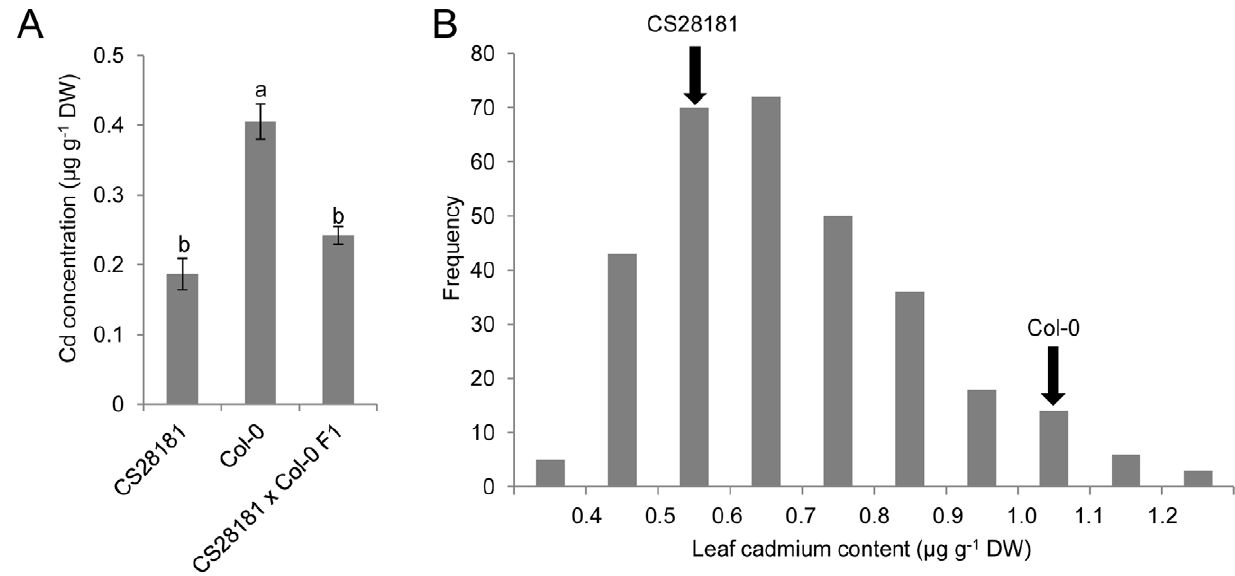
Figure 2. High leaf Cd in A.thaliana Col-0 is recessive to the low leaf Cd in the CS28181 accession. A. Leaf Cd concentration in A. thaliana accession CS28181, Col-0 and their F1 progeny. Data represent the mean leaf Cd concentration 6 standard errors (n=7–12 independent plants per genotype). B. The frequency distribution of leaf Cd concentration in F2 progeny of a cross between CS28181 and Col-0. Arrows indicate leaf Cd concentration of the parent accessions. Letters above each bar in (A) indicate statistically significant groups using a one-way ANOVA with groupings by Tukey’s HSD using a 95% confidence interval.